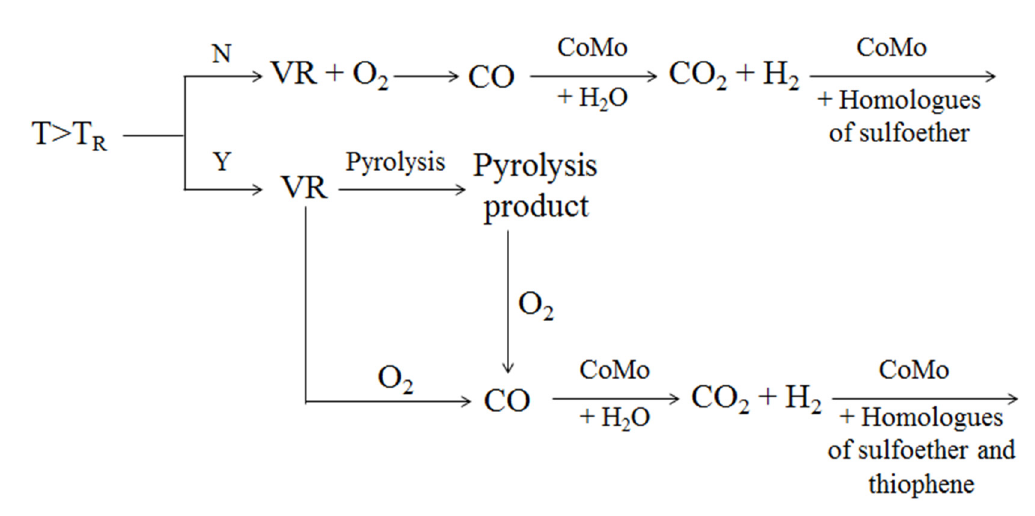
Figure 6. Sulfur reduction mechanism of VR through catalytic SCWO [101].